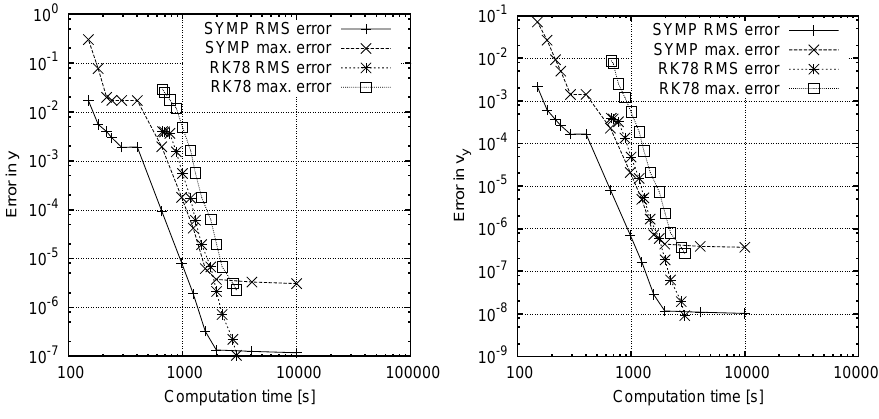
Fig. 12. The root mean square and maximum errors of the y -coordinate and it’s derivative versus the truth model in the rotating frame. that both methods converge adequately to the Poincar´e